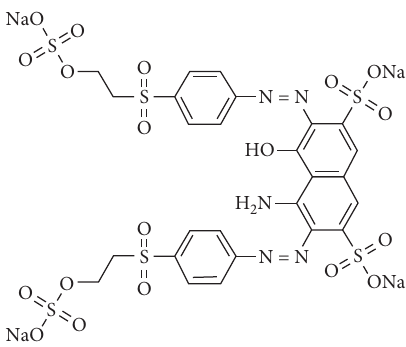
Figure 1: The structural composition of Remazol Black B